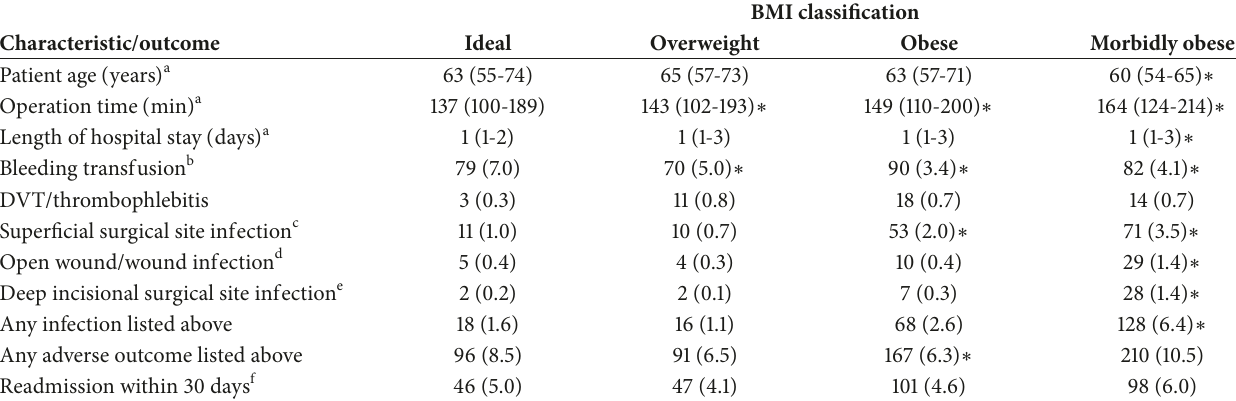
Table 2: Perioperative outcomes stratified by patient’s body mass index, ACS-NSQIP,